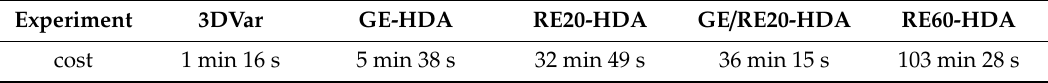
Table 1. The computational cost of each data assimilation